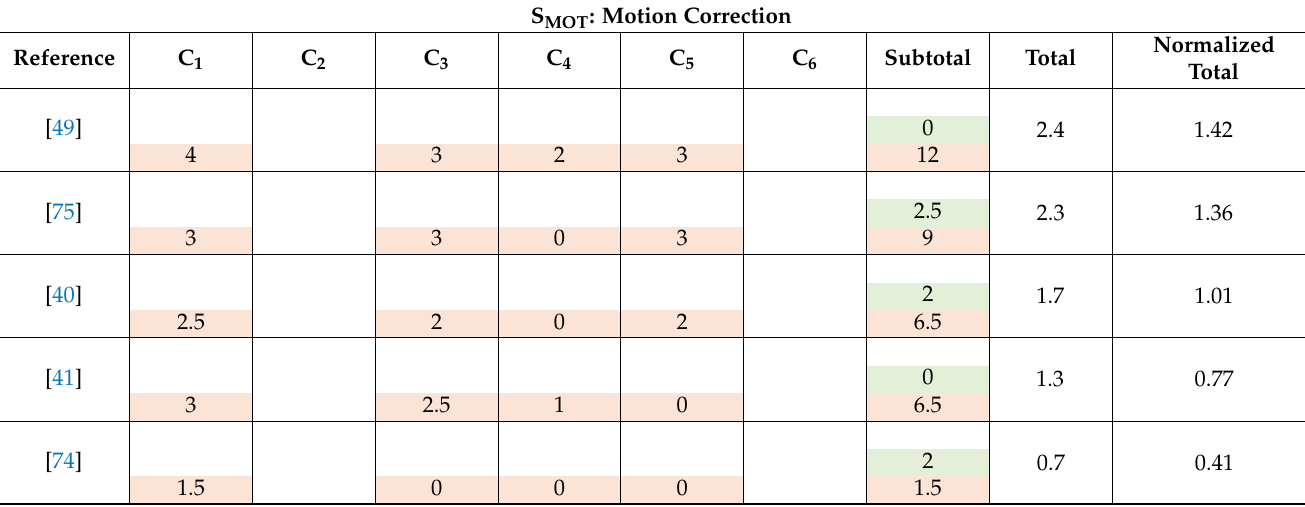
Table A4. Analytical ratings for all studies included in S MOT . The color in the table rows indicates the category of experiments as follows: experiments with synthetic motion , and experiments with humans in vivo . The columns corresponding to evaluation criteria that were not applicable to this subgroup were left